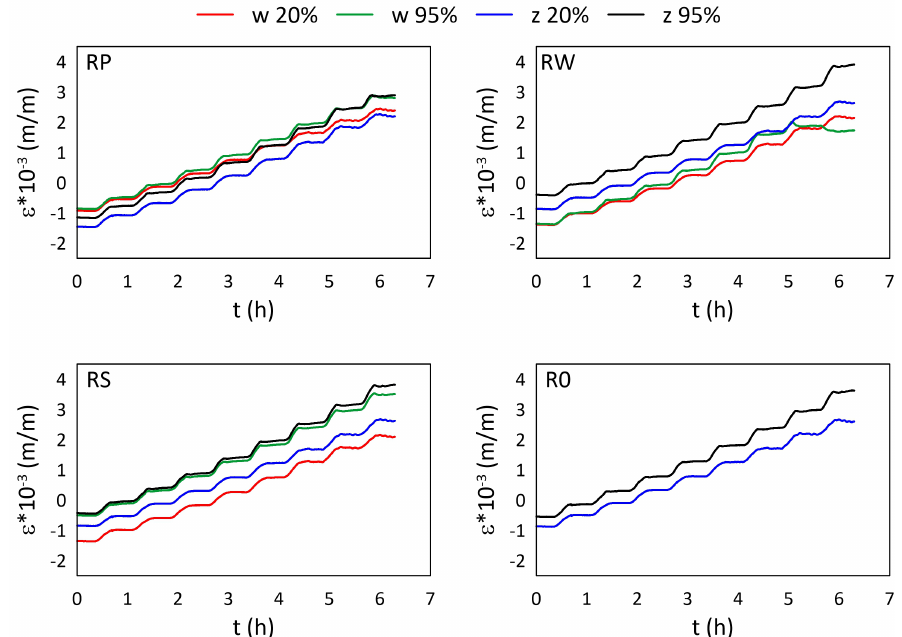
Figure 7. Strain measured by FBG sensors for M3 Crystal samples under elevated temperatures; FBG sensors: w —embedded, and z —attached.